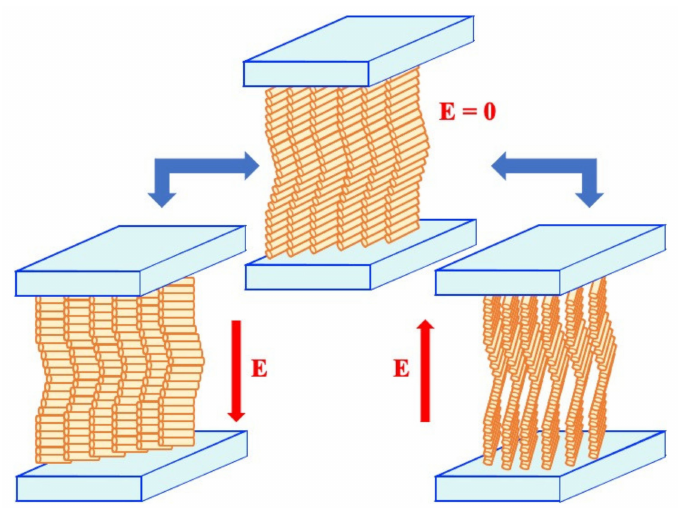
Figure 19. The expected initial molecular stacking configuration with heavily twisted structure. The smectic liquid crystal molecular stack is heavily twisted between the two substrates. The initial twisting structure may not change with applied electric field